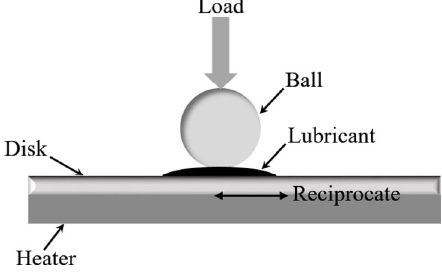
Fig. 5 Schematic diagram of the ball-on-disk sliding pair. Table 2 Conditions for sliding friction and wear tests.